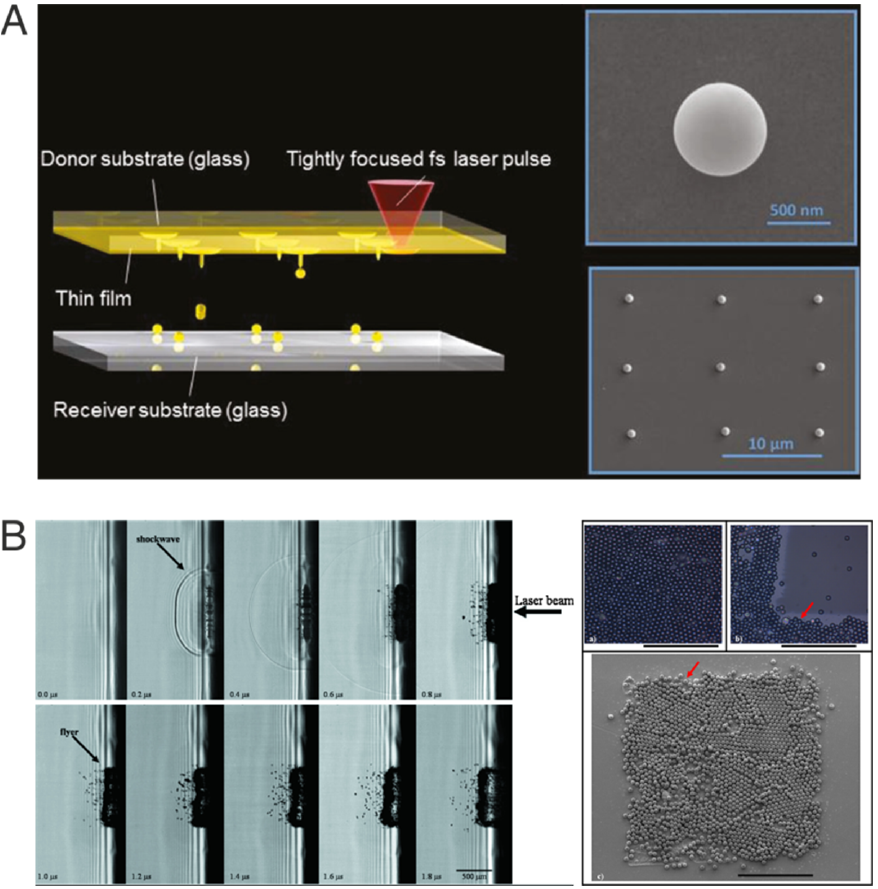
Figure 2. Printing of materials starting from a solid donor film following two different scenarios. ( A ) Melted material, where the final output corresponds to individual spherical particles. Reprinted under creative commons permission (CC BY-NC-ND 4.0) from [8], copyright 2018, De Gruyter. ( B ) In this transfer, the use of a sacrificial layer allowed the printing of an array of microspheres that followed the square shape distribution of the incident laser beam. Reprinted with permission from [9], with the permission of AIP Publishing (Copyright 2010).